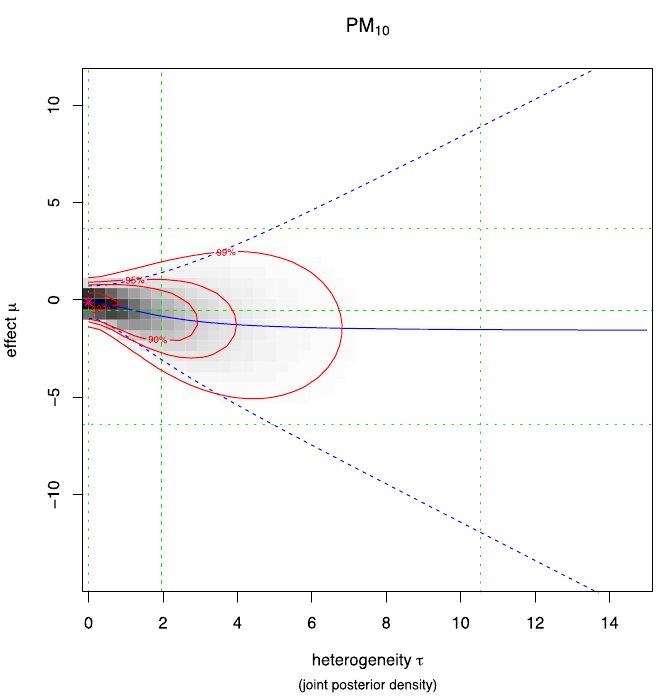
Figure 7. Heterogeneity plot PM 10 .